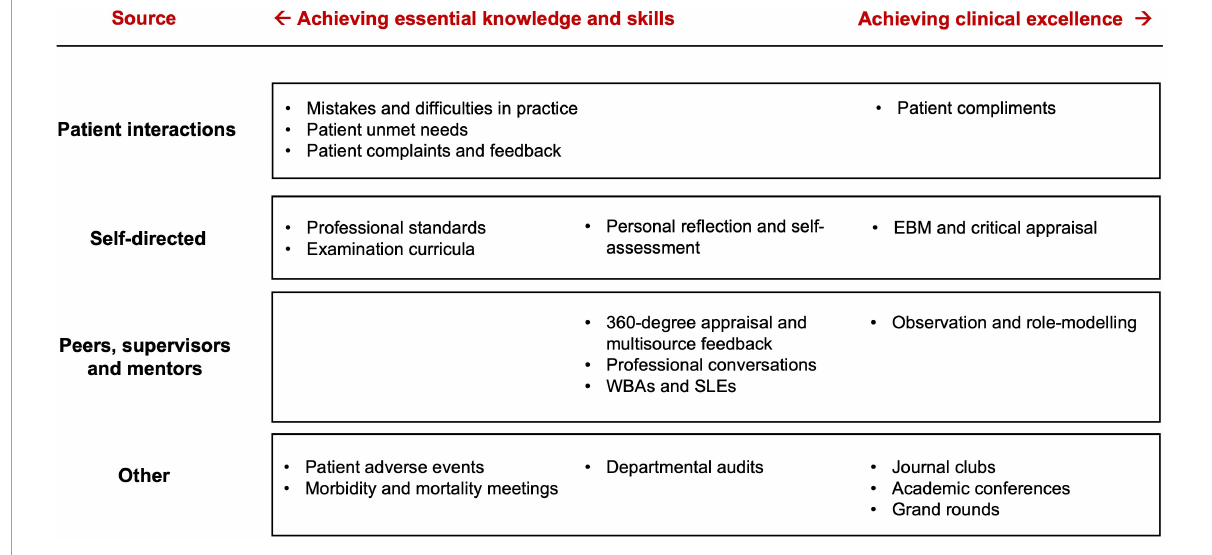
FIGURE1 What do I need to learn? A framework of workplace and educational activities which can help identify learning needs. WBA, workplace-based assessment; SLE, supervised learning event; EBM, evidence-based